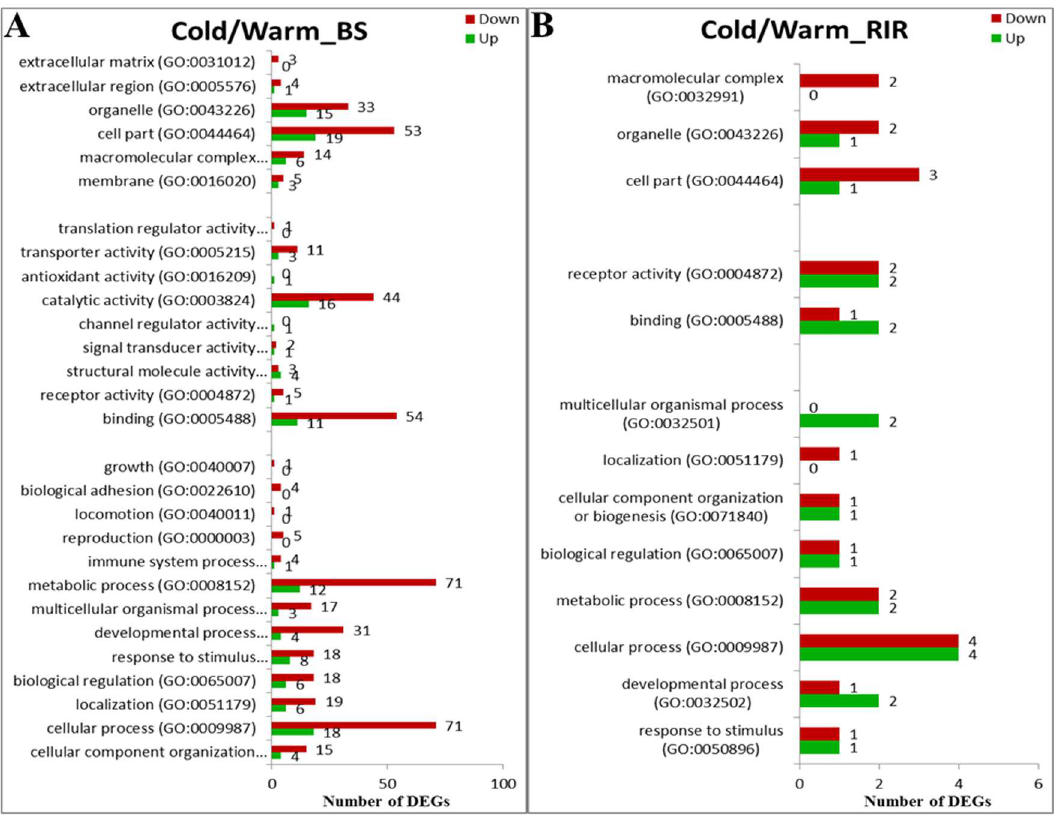
Fig 5. Functional classifications of up- and down-regulated genes for Cold/Warm_BS and Cold/Warm_RIR.